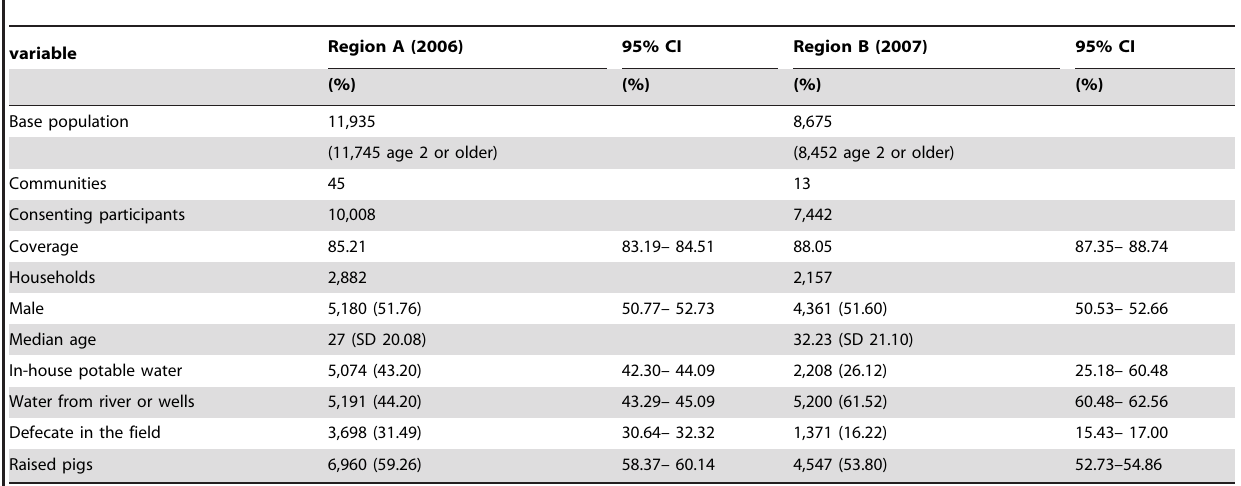
Table 1. Demographic characteristics of two wide scale cross-sectional studies in 2006 and 2007.